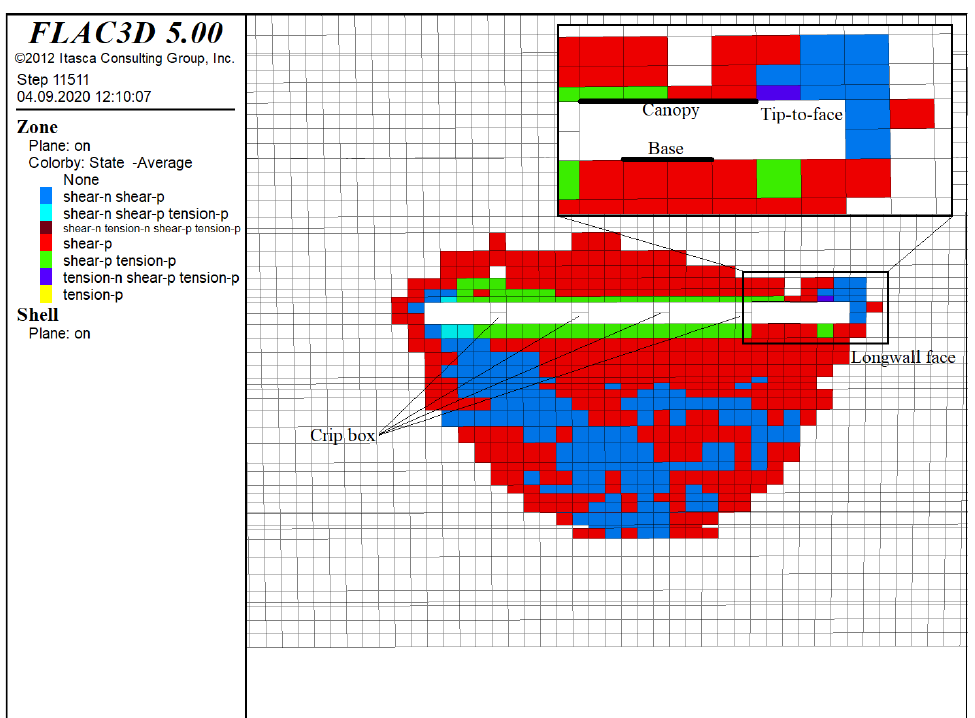
Figure 15: Failures around the longwall face using the strain-softening